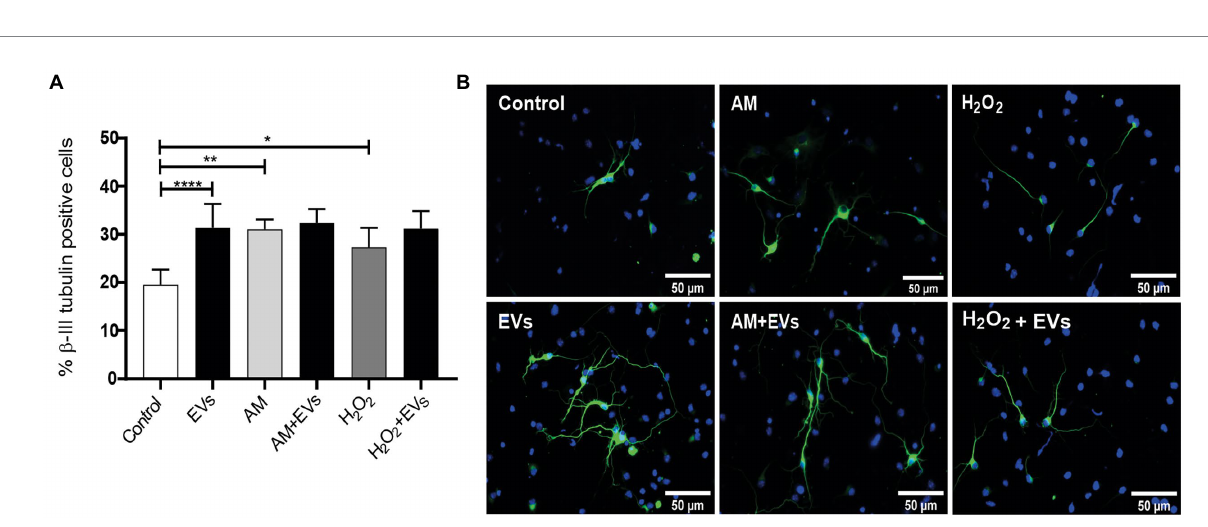
FIGURE 3 NSC-EVs induce neuronal differentiation. Neurosphere-derived cells were cultured during 3 days under differentiation conditions and immunostained with anti- β III-tubulin antibody (green). Nuclei were counterstained with DAPI (blue). (A) Percentage of β III-tubulin positive cells of NSCs exposed to oxidative stress (50 μ M H 2 O 2 or to 20% v/v of AM) in the presence or in the absence of EVs during 3 days were analysed by immunocytochemistry coupled to fluorescence microscopy. Graph represents the percentage of neuronal differentiation measured in five independent experiments. Data were presented as mean ± SEM. **** p < 0.0001; ** p < 0.01; * p < 0.05. (B) Representative images (40X) of the immunofluorescence assays with the neuronal marker ( β III-tubulin, green) nuclei (DAPI, blue). Scale bars: 50 μ